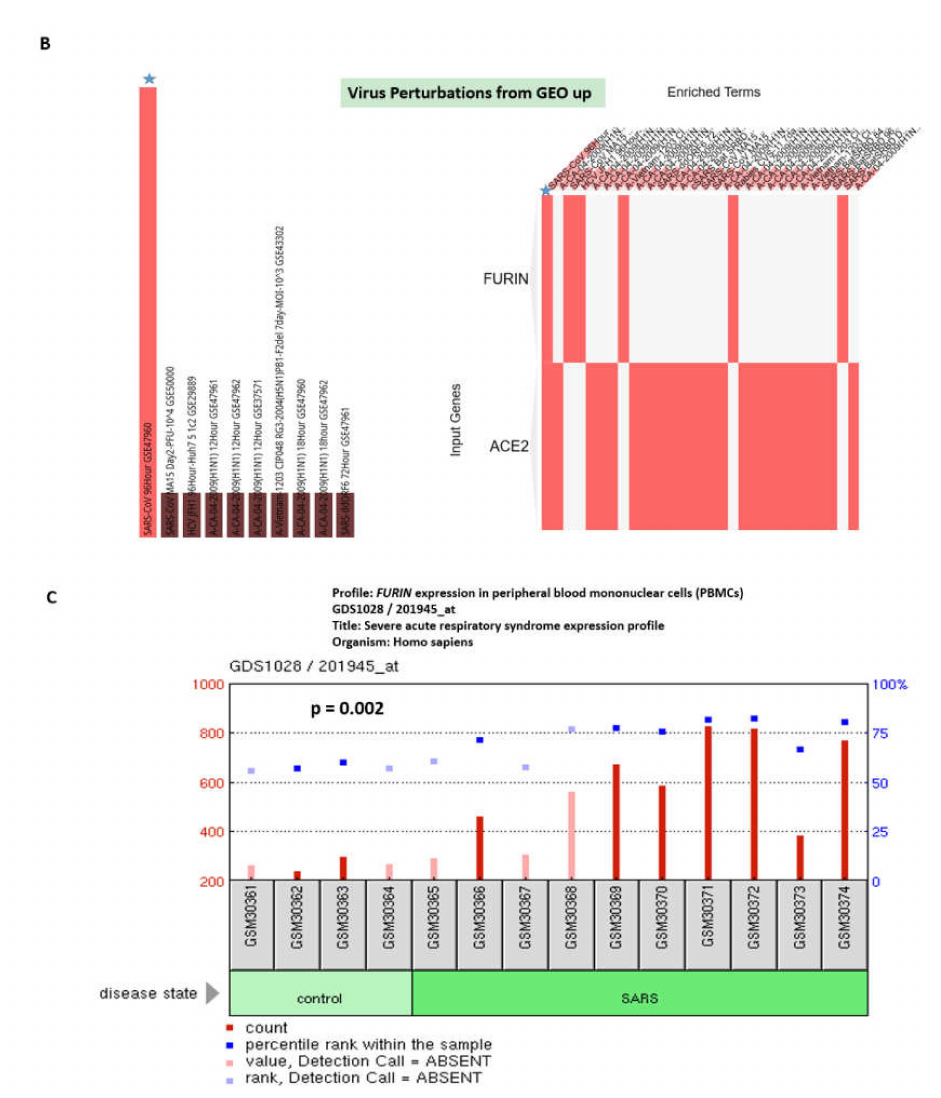
Figure 1. Genomic-guided mapping of regulatory networks a ff ecting expression of human genes encoding protein targets of SARS-CoV-2 enables identification of putative 2019 coronavirus disease (COVID-19) mitigation agents. ( A ). Flow chart of a decision-making process during the identification of candidate pandemic mitigation agents employing genomic-guided tracing of genetic regulators and biological and chemical e ff ectors of SARS-CoV-2 targets in human cells. ( B ) and ( C ). E ff ects of viral challenges on expression of the ACE2 and FURIN genes. ( B ). Gene Set Enrichment Analyses (GSEA) of the Virus Perturbations from GEO focused on upregulated genes (Enrichr bioinformatics platform). SARS-CoV p value = 0.0002; q value = 0.072). Star denotes the SARS-CoV record at the 96 hrs. ( C ). Increased FURIN expression in peripheral blood mononuclear cells (PBMC) of patients with severe acute respiratory syndrome (SARS). p value = 0.002; q value =